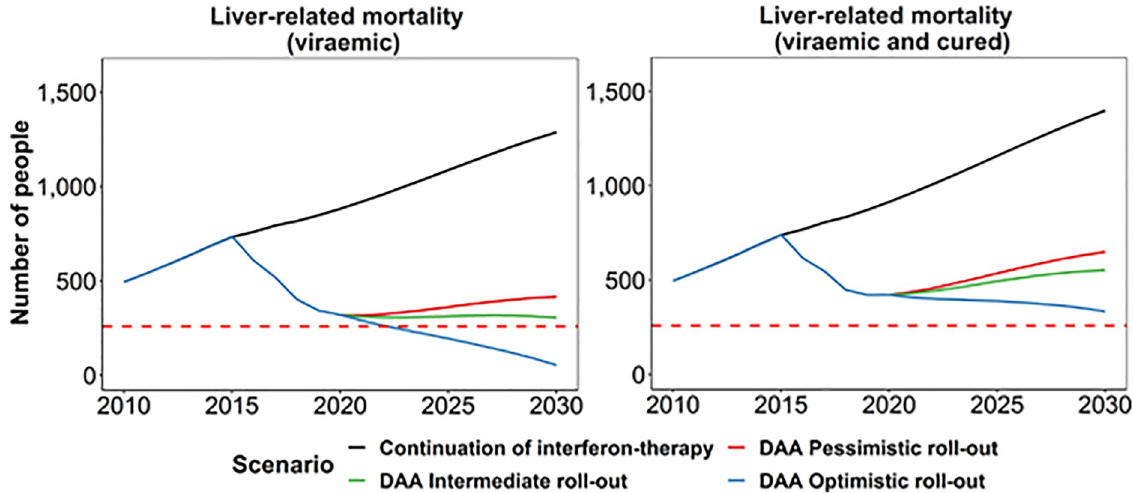
Fig 4. Liver-related mortality among viraemic only and viraemic and cured combined in Australia 2010–2030 compared to WHO HCV mortality target (red dotted lines: 65% reduction from